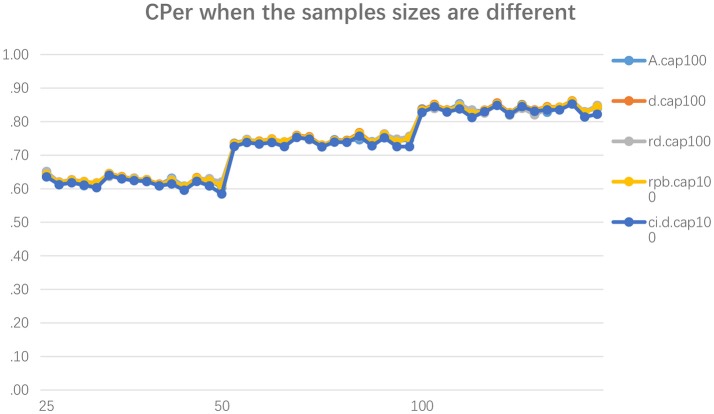
Capture Percentages across 45 conditions when the sample sizes in the original and replicated studies are different. The y-axis shows the capture percentage. The x-axis is the sample sizes for the original study. A.cap0 is the CPer for A, d.cap100 is the CPer for Cohen's d, rd.cap100 is the CPer for robust d (dr), rpb.cap100 is the CPer for point-biserial correlation (rpb). The notation cap100 implies that the capture procedure should result in a successful (i.e., about 83.4%) capture procedure because the true effect sizes are the same in the original and replicated studies. All these CPer methods are calculated based on the bootstrap CIs. The last term, ci.d.cap0, refers to the CPer based on the analytic CI surrounding Cohen's d.